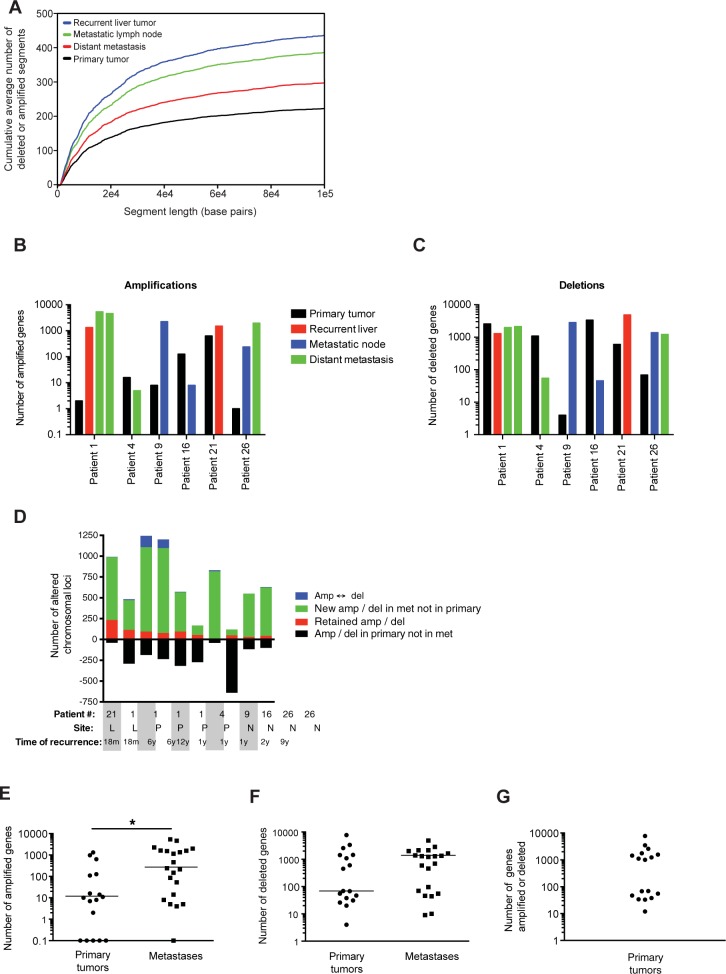
Genomic alterations are common in FL-HCC.(A) Cumulative average number of genomic segment amplifications and deletions in primary liver tumors, recurrent liver tumors, metastatic lymph nodes, and distant metastases. (B) Total number of genes amplified or deleted (C) in patients with primary and metastatic lesions. (D) Number of amplifications (amp) and deletions (del) gained, lost, or retained in metastatic tumors of the liver (L), peritoneum (P), or lymph nodes (N). Amp ↔ del refers to genes amplified in primary but deleted in metastatic tumors, or deleted in primary but amplified in metastatic tumors. Number of genes amplified or deleted in primary or metastatic tumors for all patients (E,F) and distribution of genomic alterations in primary tumors (G). Lines on dot plots represent medians. *, p<0.05.